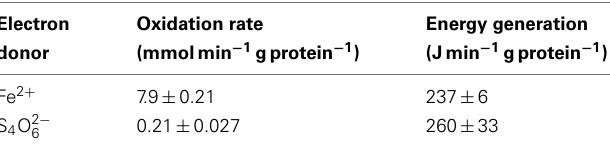
Table 6 | Comparison of the specific rates of ferrous iron and tetrathionate oxidation by Acidithiobacillus sp.ATCC 33020, and conversion of these into specific rates of energy generation in unit